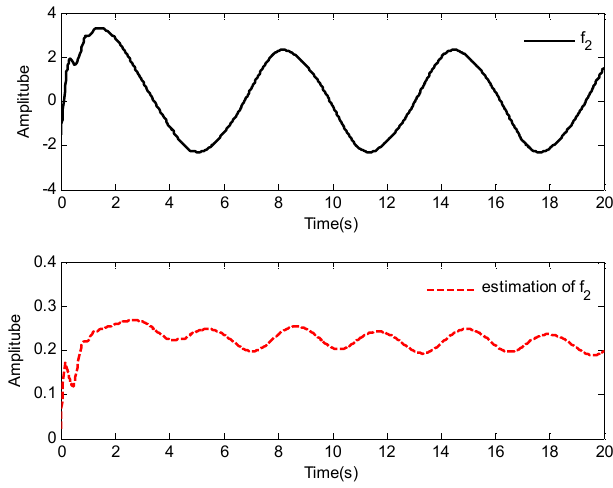
Figure 11. Response of f 2 and ˆ f 2 .